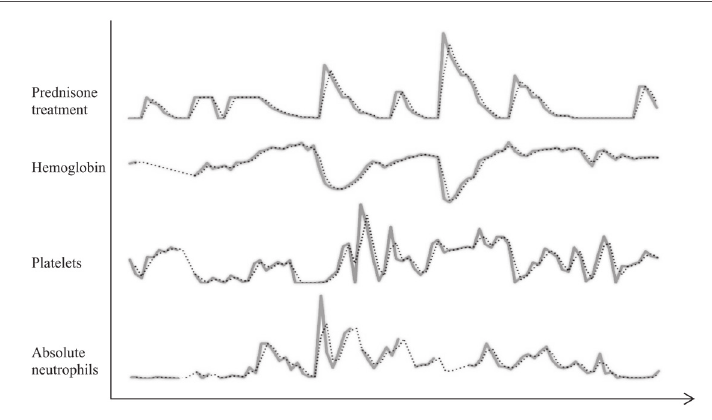
Figure 2. Relationship of Prednisone Treatment to Hemoglobin, Platelet and Absolute Neutrophil Counts in Patient with Probable ALPS over an Eight-Year Period. A Moving Average Two-period Trend-line has been added (Dotted Line)